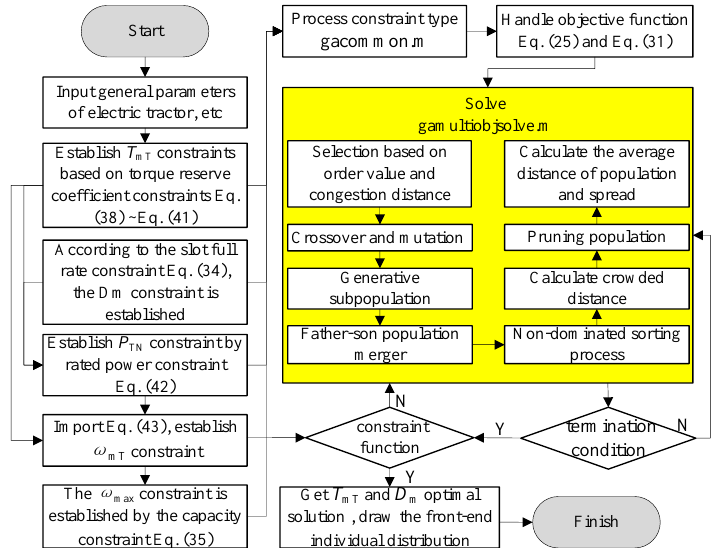
Figure 3. Optimization algorithm of the drive motor. The optimal front-end individual coefficient of the NSGA-II algorithm is set to 0.3, the population size is 200, the maximum evolutionary algebra is 500, the stop algebra is 500, and the fitness function value deviation is 1 × 10 − 1000 . Figure 4 shows the individual front-end distribution of the parameter set of the drive motor of the electric tractor. On the basis of Equation (29) and objective function Equation (32), when the value of τ 1 is the same, the total efficiency of the electric tractor drive system is the same. From Equation (30) g tx ( D m , T mT , ω max ) is established, and g emt ( D m , T mT , ω max ) is substituted. The figure shows that when τ 1 = 1, the heat loss of the drive motor is high; when τ 1 = 2, f Amt ( D m , T mT ) and g tx ( D m , T mT , ω max ) has a nonlinear inverse relationship. In the solution set of τ 1 = 2, a large g tx ( D m , T mT , ω max ) corresponds to a slight heat loss. The design values of the motor parameters are calculated by D m , T mT , and ω max corresponding to the individual point C.